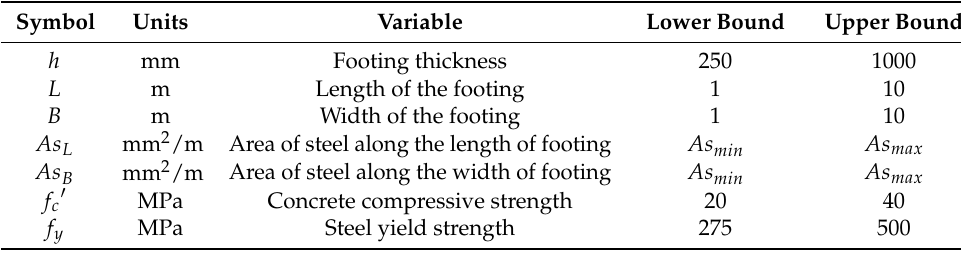
Table 1. Variable Bounds used in